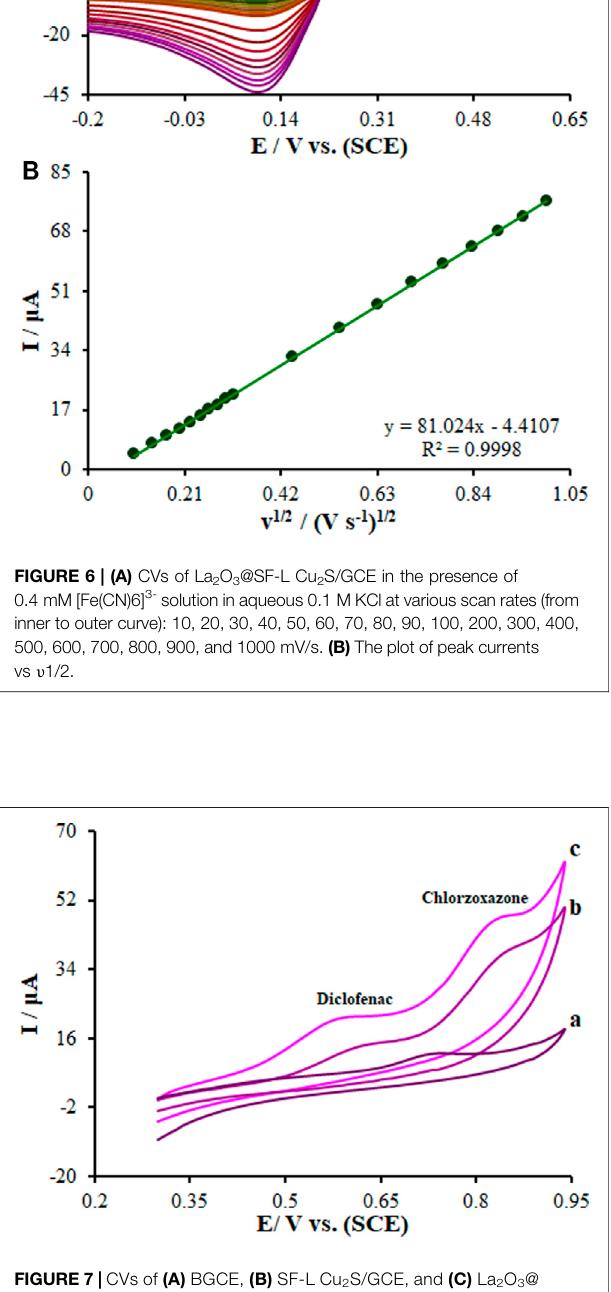
FIGURE 7 | CVs of (A) BGCE, (B) SF-L Cu 2 S/GCE, and (C) La 2 O 3 @ SF-L Cu 2 S/GCE in the presence of diclofenac (275.0 µM) and chlorzoxazone (275.0 µM) at a pH 7.0, respectively. In all cases, the scan rate was 50 mV s − 1